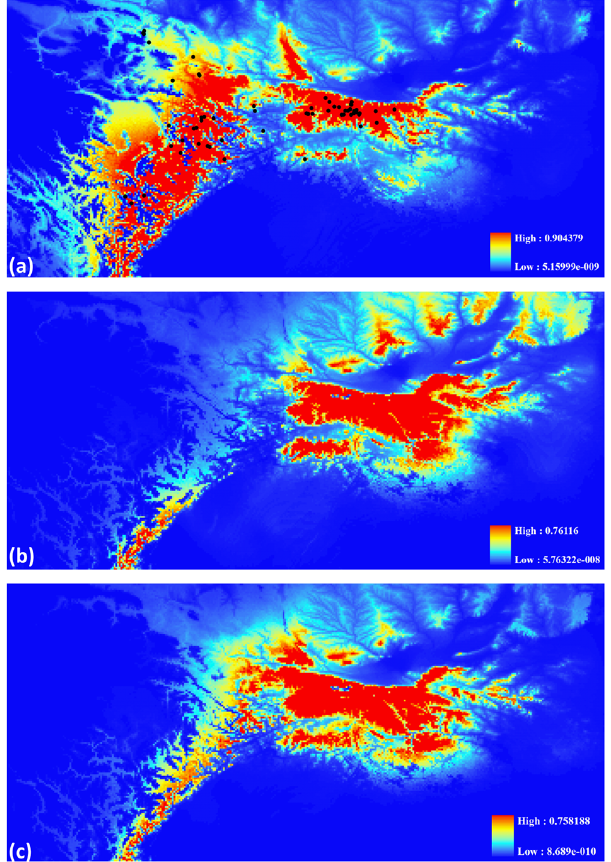
Figure 4. Ecological niche modelling (ENM) predicts the current ( a ) and last glacial maximum (LGM) ( b ), CSSM model; ( c ), MIROC model suitable distribution area for B . tibetanus . Circles indicate known sampling localities used in ENM analyses. The map was generated using ArcGIS 9.3 (ESRI) and Adobe Illustrator CS4 v14.0.0 (Adobe Systems Inc., San Francisco,